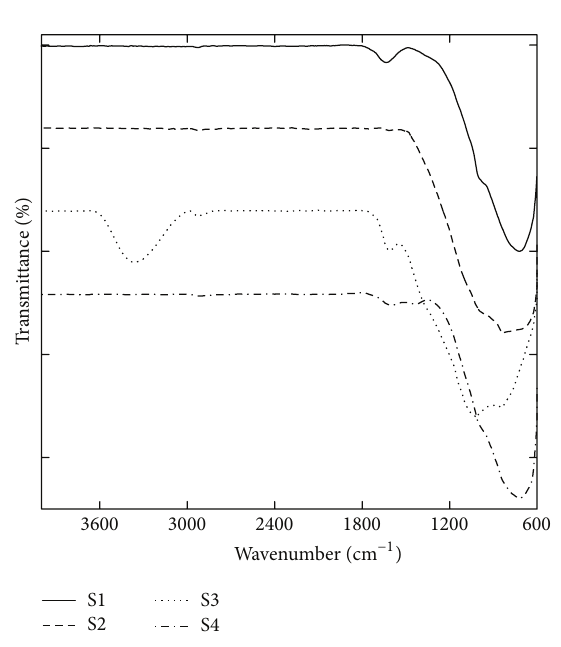
Figure 10: IR spectra of Zuota